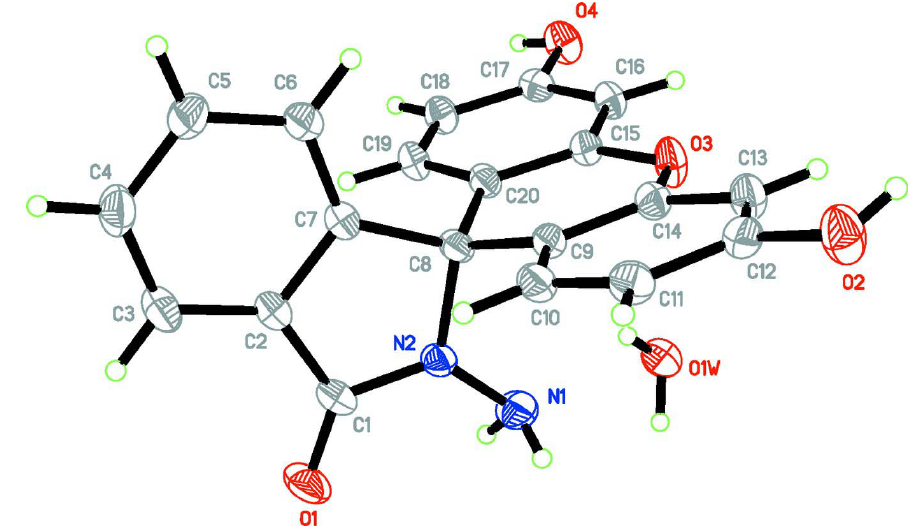
The asymmetric unit, with the atom-numbering scheme. Displacement ellipsoids are drawn at the 30% probability